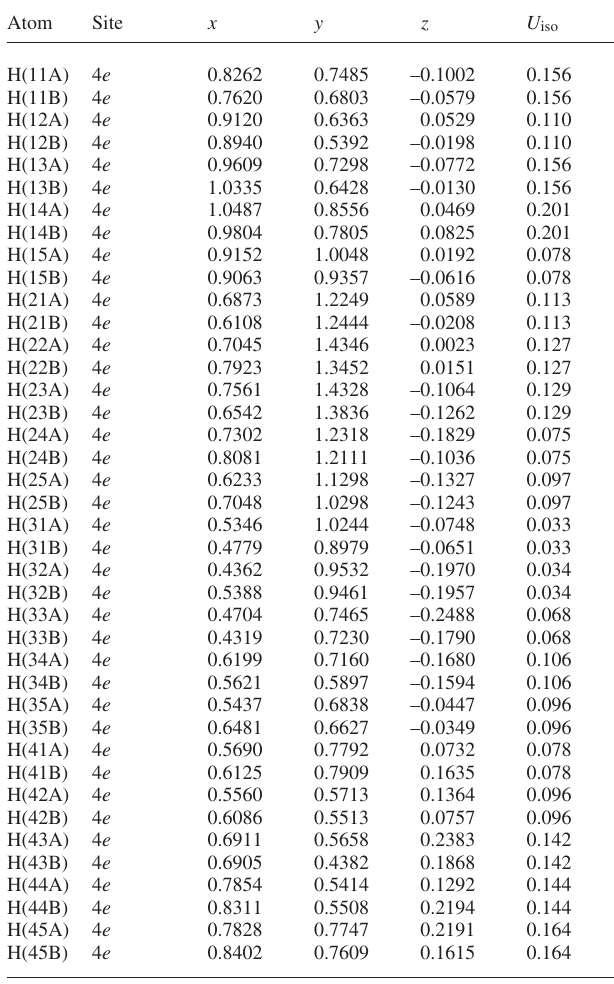
Table 2. Atomic coordinates and displacement parameters (in Å 2 )